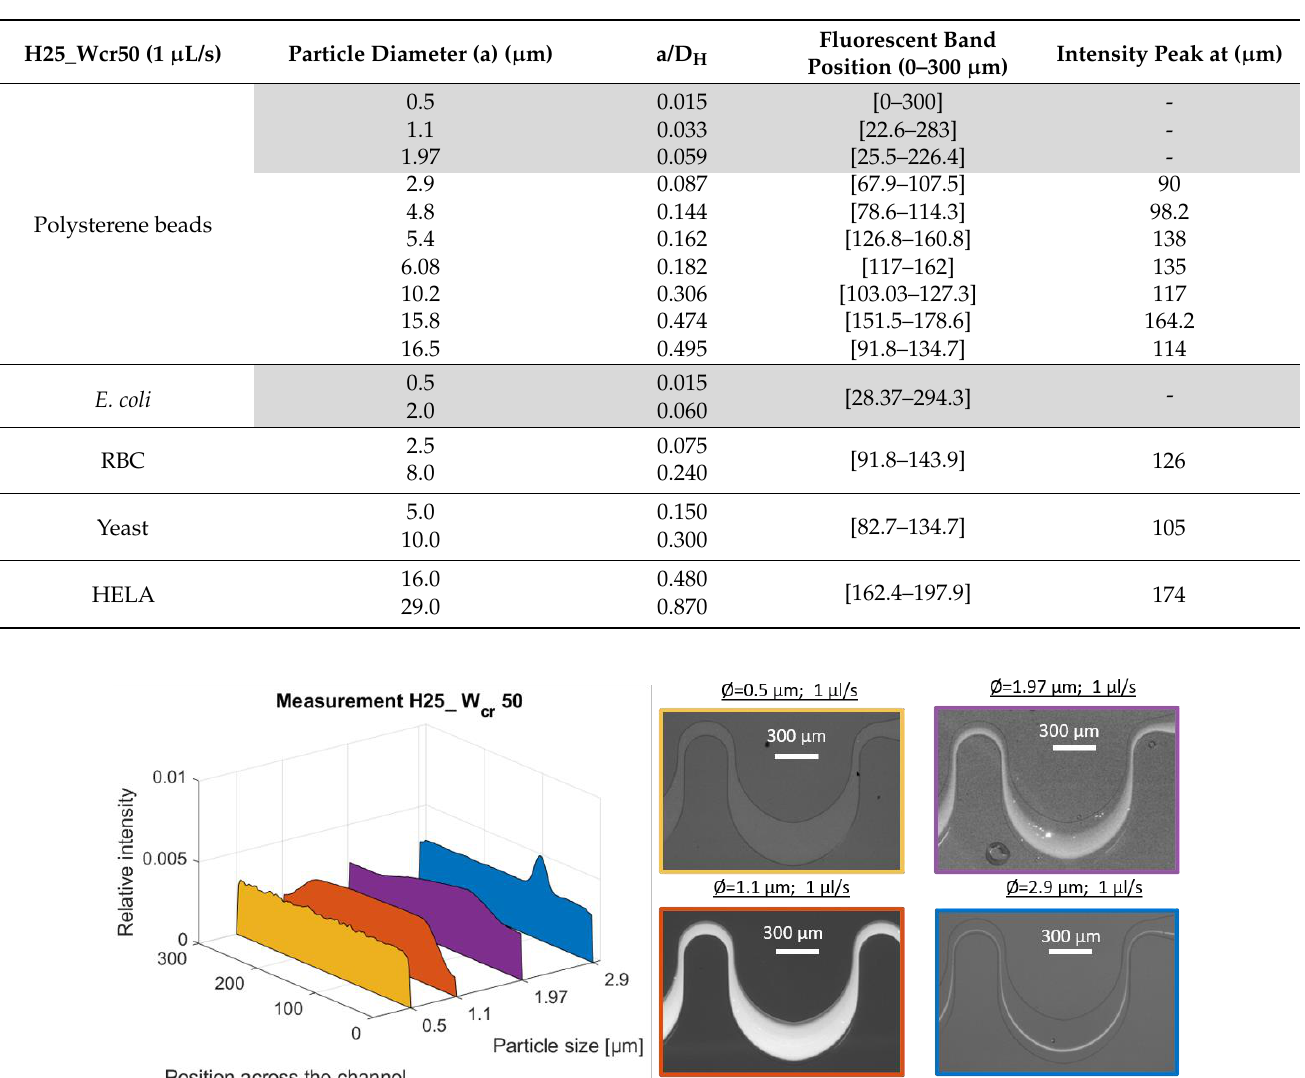
Figure 5. Lateral focusing of biological cells and their rigid model beads in channel H25_W cr 50 at 1µL/s flow rate. The size and morphology of the applied biological sample were studied in a Bürker chamber ( A ), and their lateral positions were captured by fluorescent or dark-field microscopy at the end of the channel in the big curvature ( B ). The equivalent diameter of the studied model beads was determined by the maximal overlapping of the lateral-focusing positions compared to the given cell. ( C ) is the polystyrene bead profiles that best describes the lateral focusing position and profile of the given cell sizes. 4.4. Focusing of Red Blood Cells The shape of a red blood cell is bicoid biconcave, the average cell size is between 6 and 8 µm [36], and its thickness can be 2.5 µm [35]. One droplet of blood was diluted 100× times and the diameter of the model fluorescent rigid beads was 2.9, 4.8, 5.4 and 6.08 µm,